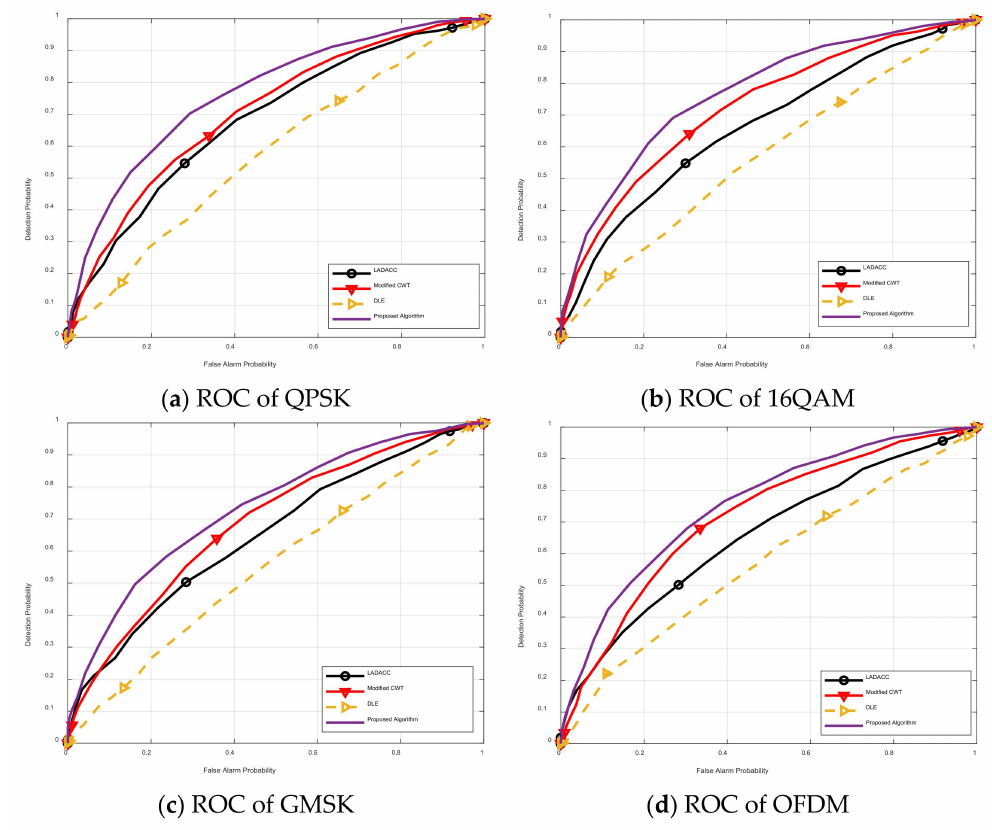
Figure 12. ROC at − 13 dB under AWGN channel.